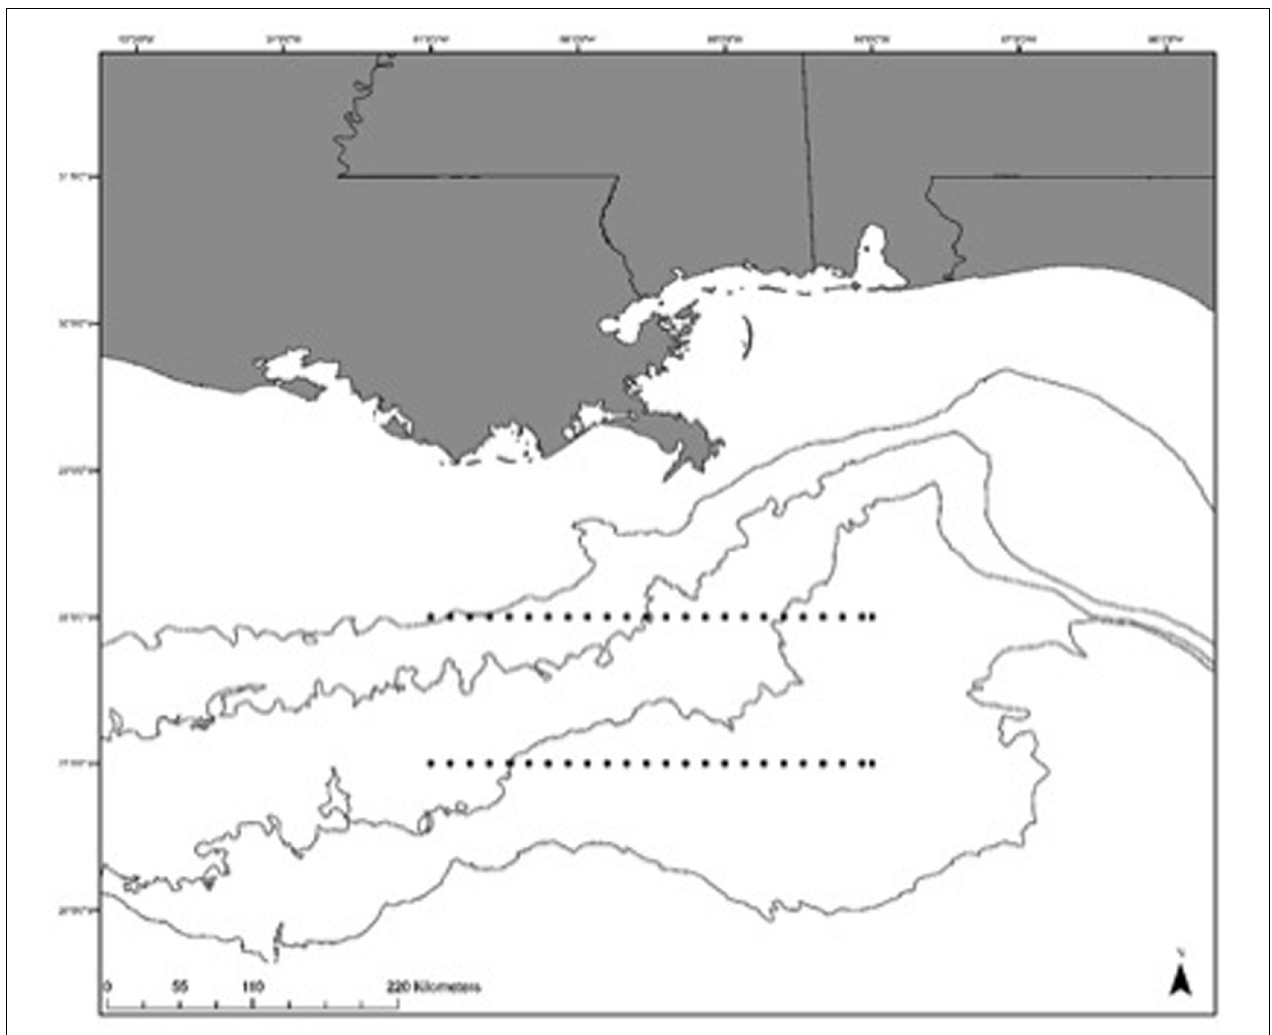
FIGURE 1 | Sampling sites (black dots) of the June and July ichthyoplankton cruises performed in 2015 and 2016 in the Northern Gulf of